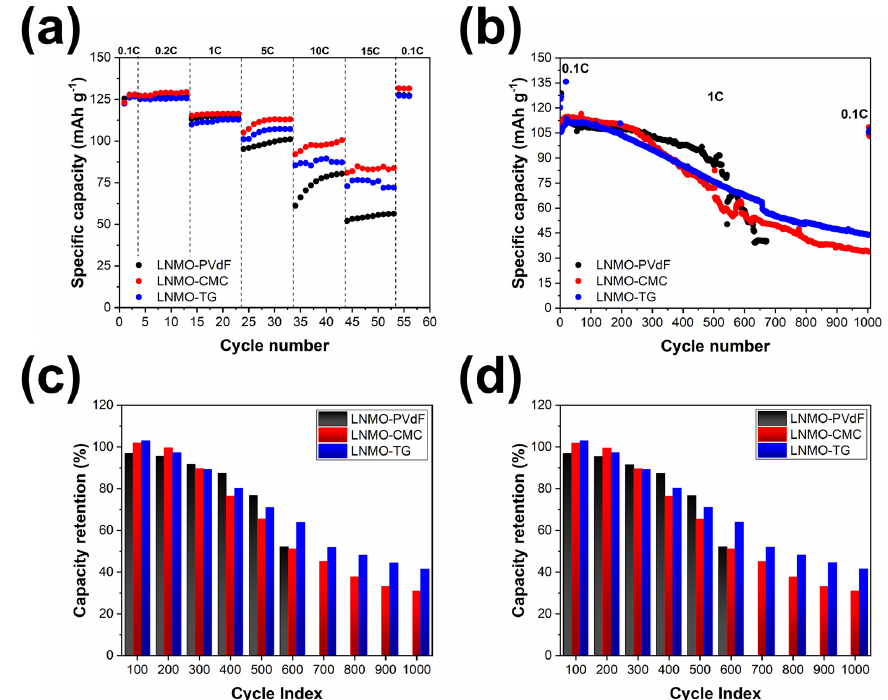
Figure 4. Electrochemical results for half-cell LNMO electrodes containing different binders: ( a ) comparison of the discharge capacity at different C-rates over a wide range of discharge-current densities (0.1–15 C), charge current fixed at 1 C; ( b ) comparison of long-cycling performance (half cells cycled at 0.1 C for 3 cycles and 1 C for further cycles); ( c ) comparison of charge-capacity retention percentiles; ( d ) comparison of discharge-capacity retention percentiles. Cycling at 25 ◦ C between 3.5 V and 4.9 V. Table 2. Summary of discharge-capacity and coulombic-e ffi ciency performance at di ff erent C-rates of LNMO electrodes with di ff erent binders.